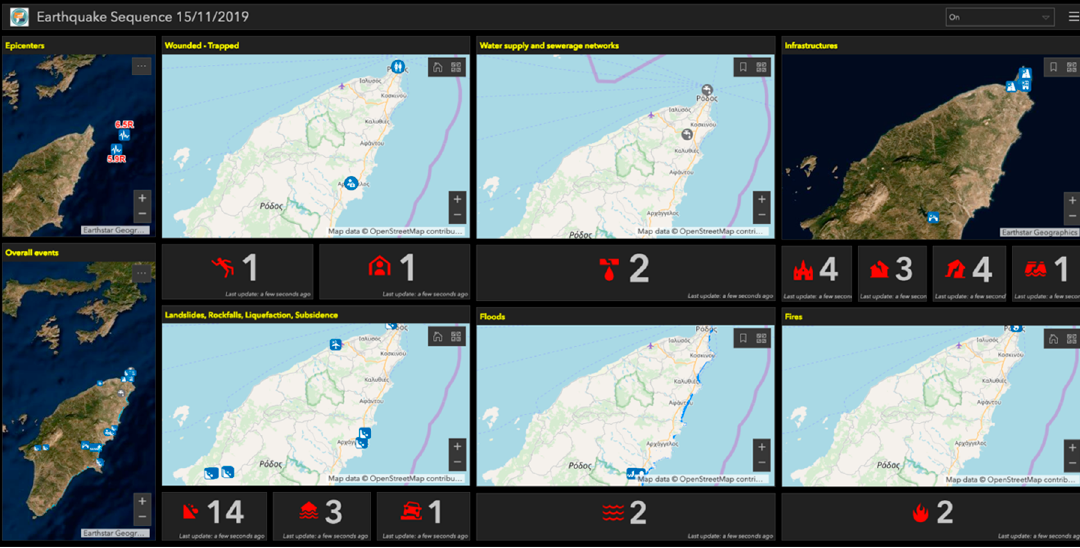
Figure 4. Interactive dynamic dashboard presenting real-time damage to infrastructure and casualties during an earthquake event (https://arcg.is/0LSmHj).